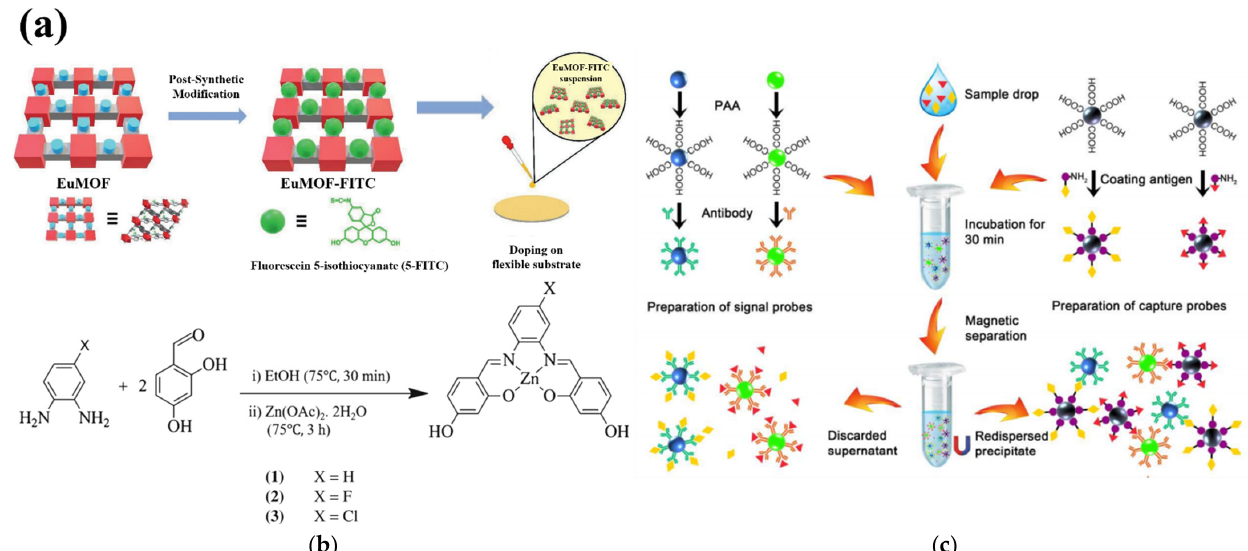
Figure 2. ( a ) Schematic diagrams of the preparation of EuMOF-FITC and EuMOF-FITC loaded films [81] ; ( b ) synthesis of zinc (II) salphen complexes [86] ; ( c ) schematic diagram of material preparation for multiple fluorescence immunoassays [95] .